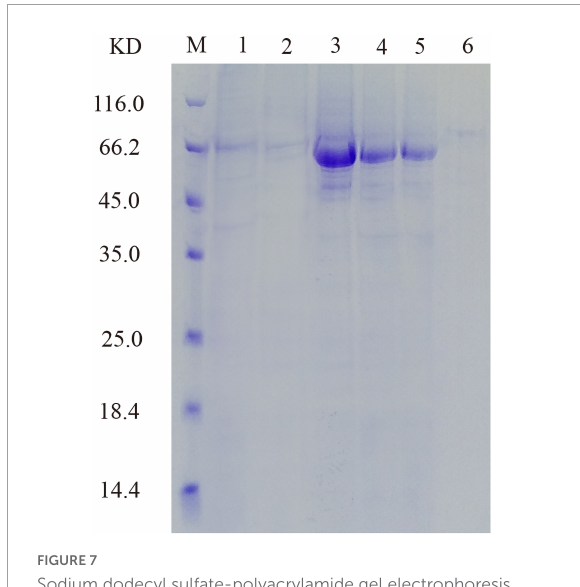
FIGURE7 Sodium dodecyl sulfate-polyacrylamide gel electrophoresis (SDS-PAGE) analysis of the recombinant PHY101. M: Protein molecular weight marker; Lane 1: 96 h of culture to secrete supernatant; Lane 2: Effluent solution through column; Lane 3–6: Elution solution through